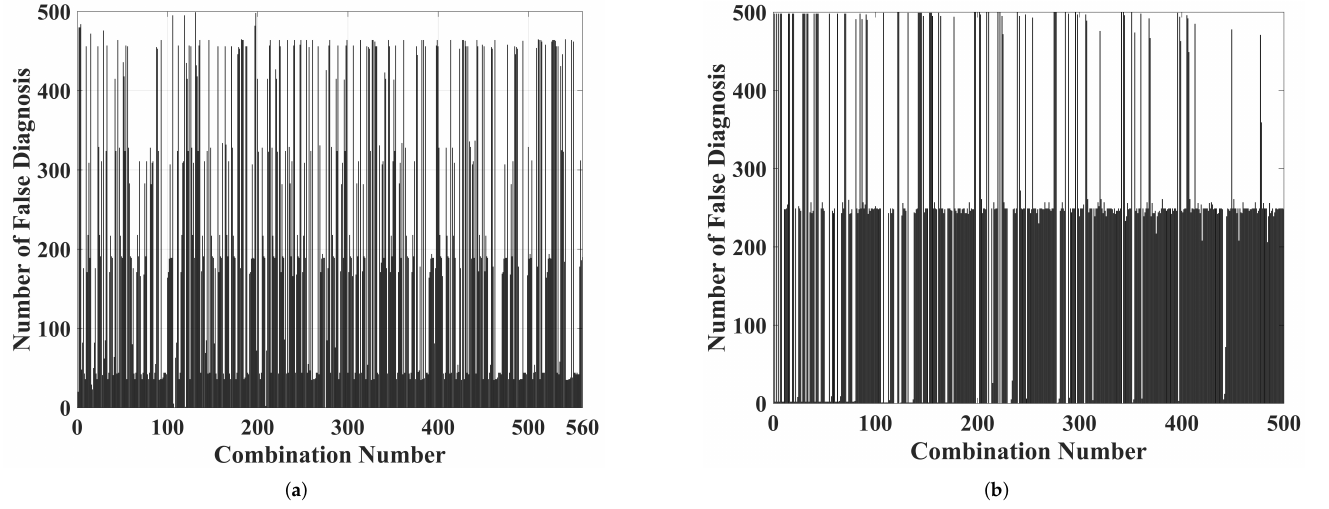
Figure 7. The number of false diagnoses for each combination (presented in the Appendix A) of three levels for ( a ) approximation and ( b ) detail